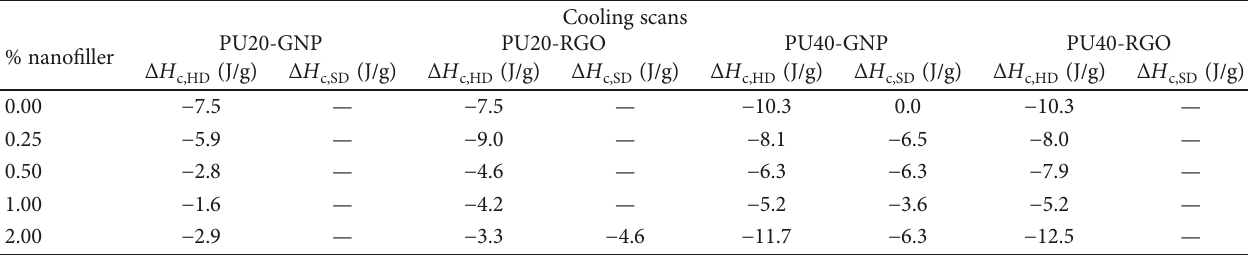
Table 5: Enthalpy of crystallization for PU nanocomposites (cooling scans).